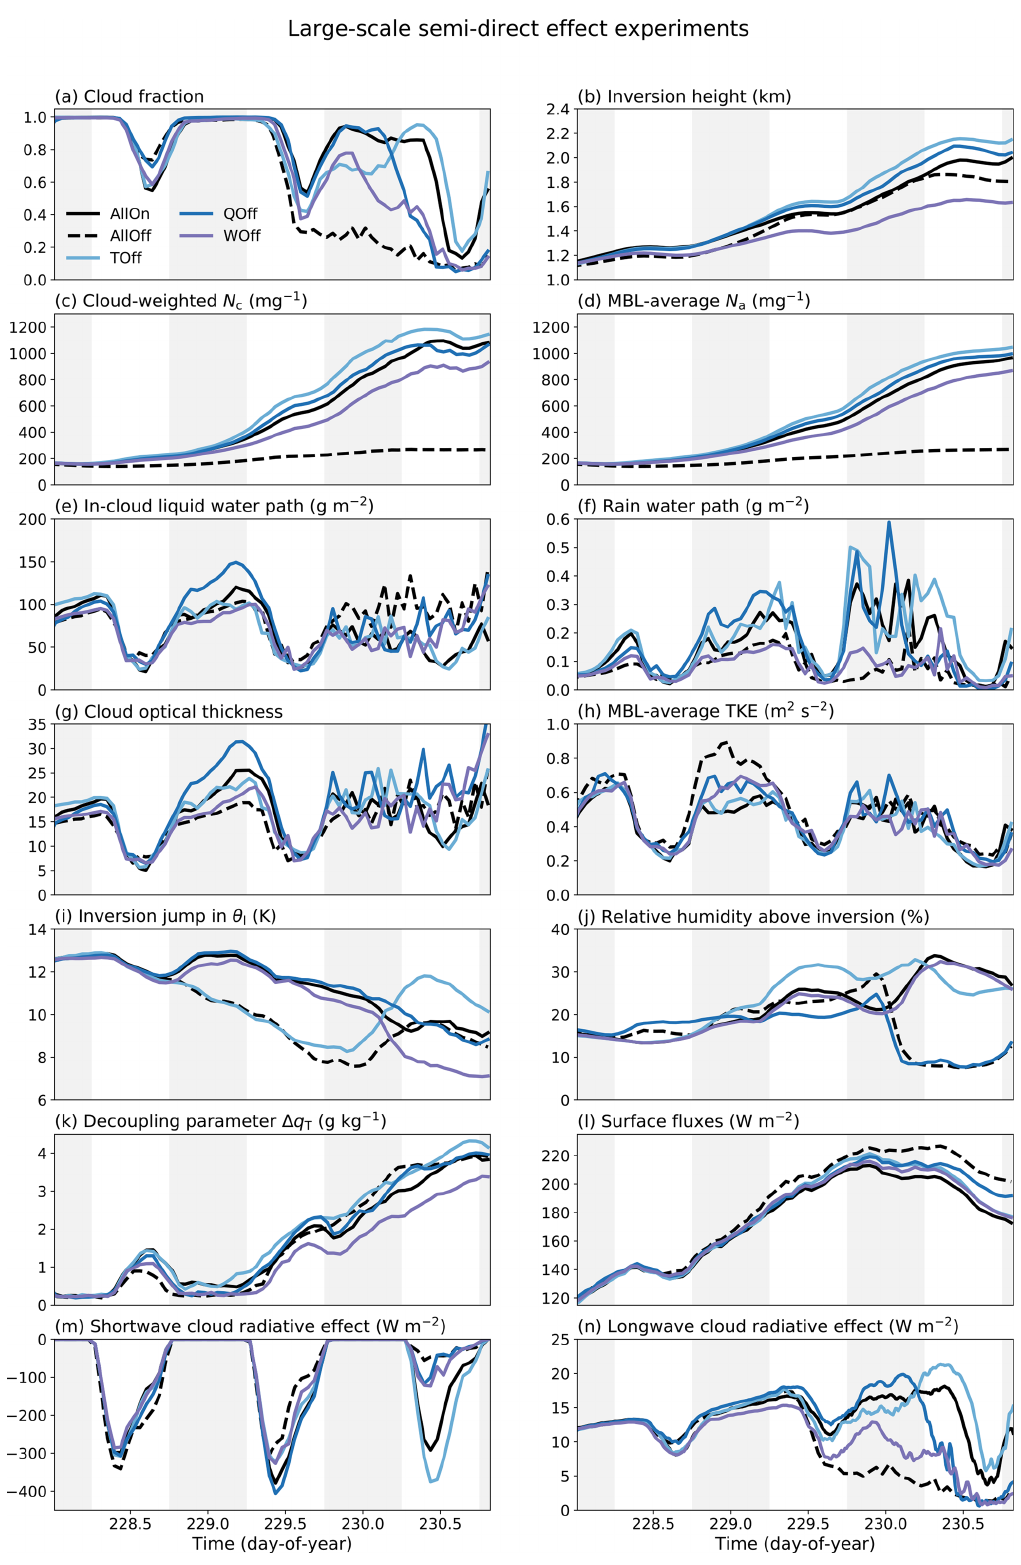
Figure 16. Evolution of various cloud and MBL properties over the course of the Lagrangian simulations for AllOn and AllOff along with the large-scale semi-direct effect focused sensitivity tests. Subplots as in Fig. 15 but for TOff (light blue), QOff (dark blue) and WOff (purple).